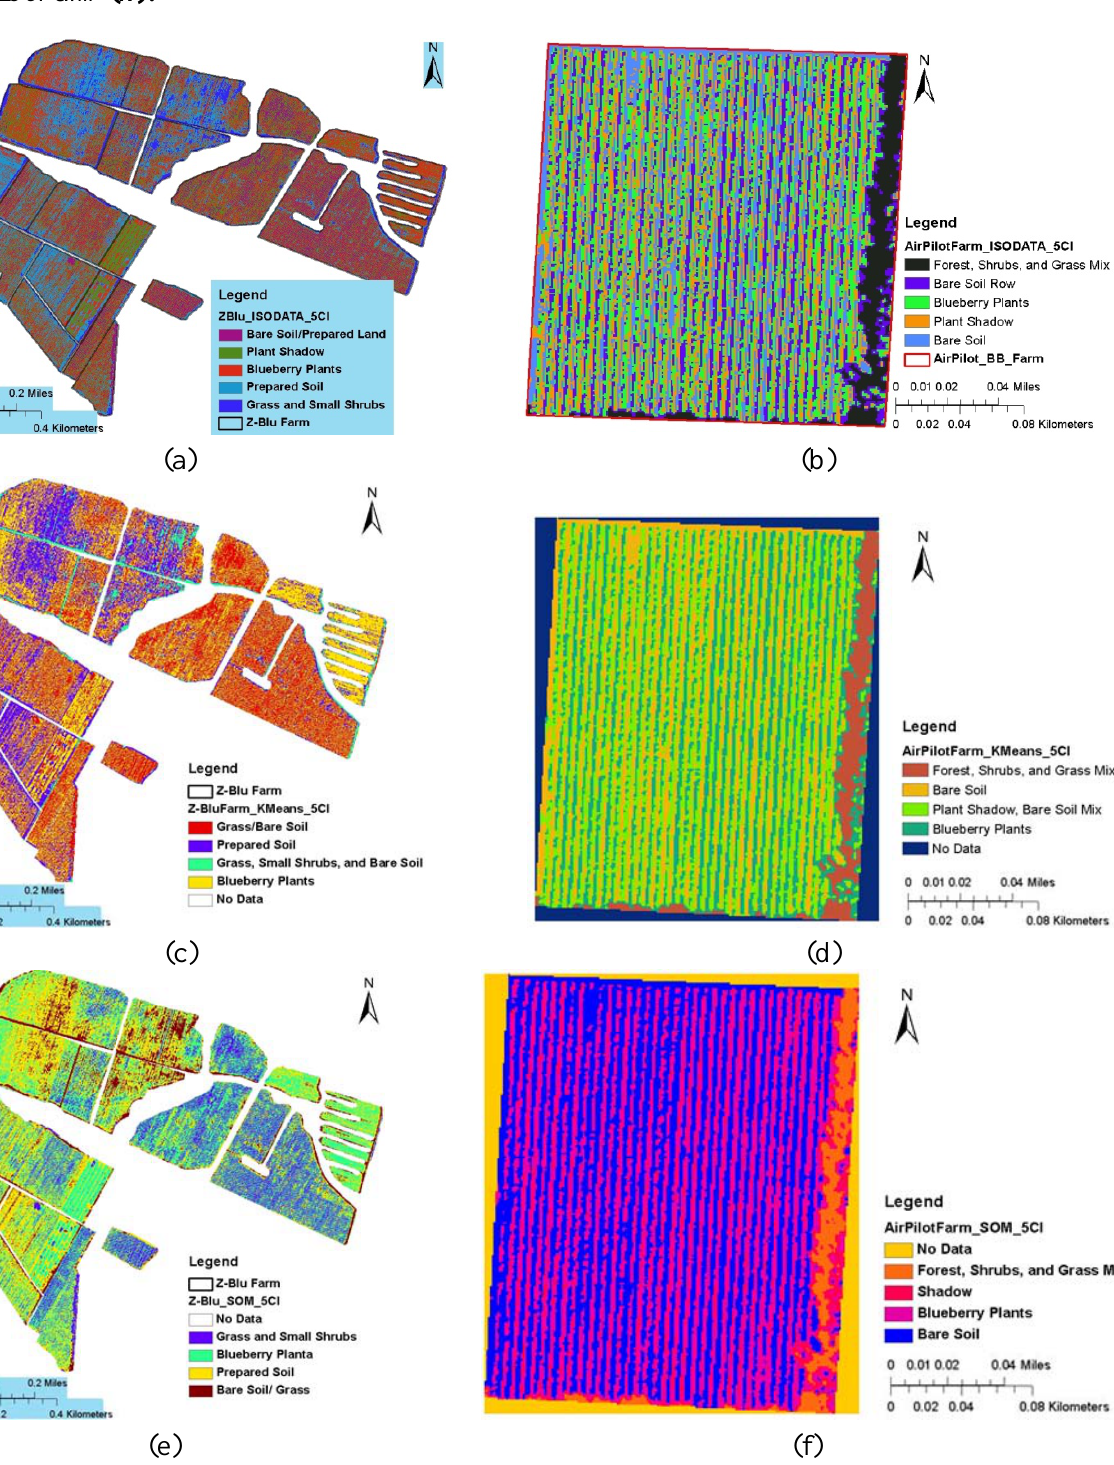
Figure 4. Comparison of different classification algorithms in blueberry plants differentiation from other land-use in blueberry orchards of Z-Blu Farm in Nahunta, GA and Air-Pilot Farm in Woodbine, GA, U.S. ISODATA clustering segmentation of the NAIP image of the Z-Blu Farm (a) and of the Air Pilot Farm (b) ; K-means clustering segmentation of the NAIP image of the Z-Blu Farm (c) and Air Pilot Farm (d) ; SOM clustering segmentation of the NAIP image of the Z-Blu Farm (e) and Air Pilot Farm (f) ; and ISODATA clustering segmentation of the NAIP image of the Z-Blu Farm (g) and Air Pilot Farm